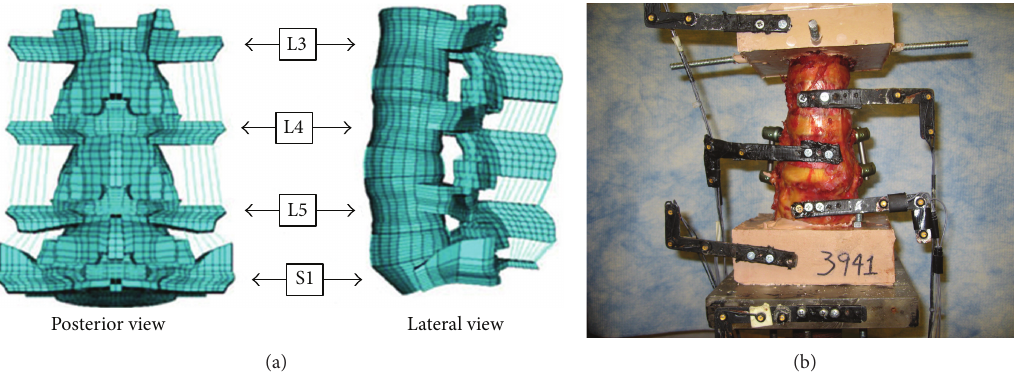
Figure 1: (a) FE model of the lumbar spine (E-CORE, University of Toledo), (b) the lumbar spine specimen with posterior dynamic stabi- lization